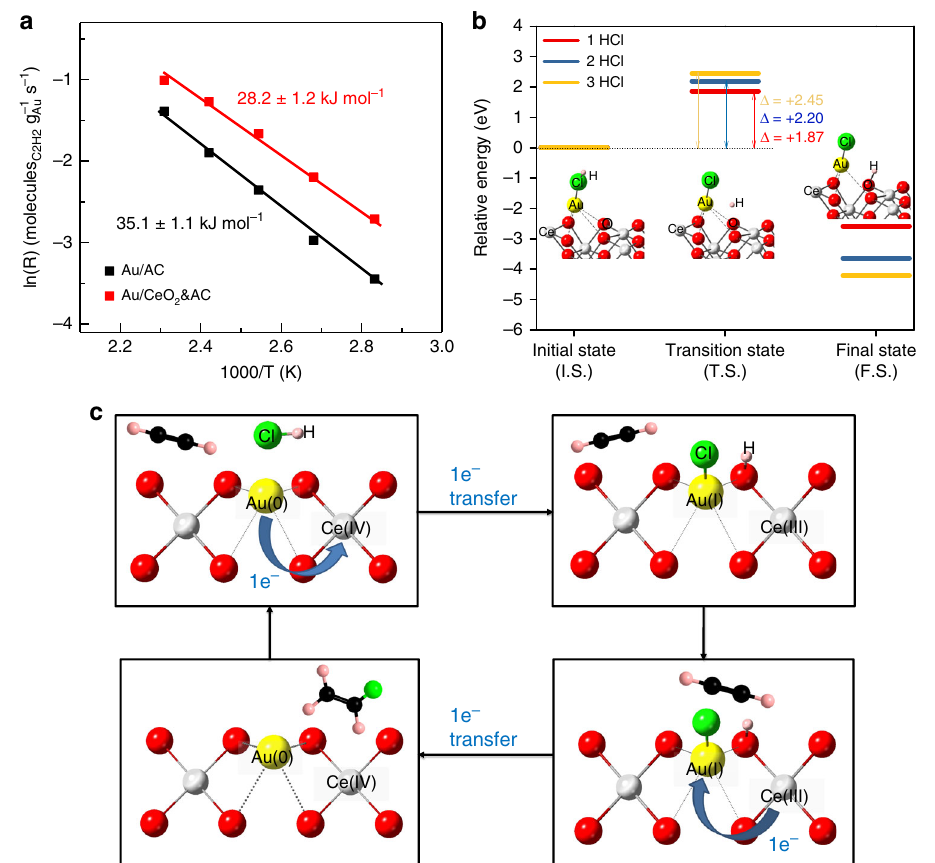
Fig. 4 Experimental and theoretical catalytic activity. a Arrhenius plots for 1.0 wt% Au/AC and 1.0 wt% Au/CeO 2 &AC (the number after ‘ ± ’ represents the error). b The potential energy diagrams for 1HCl, 2HCl, and 3HCl molecules on Au/CeO 2 (110) surface with the optimized geometry of the initial state, transition state, and fi nal state, respectively (Supplementary Figure 10). Oxygen, cerium, gold, chloride, and hydrogen are depicted in red, white, yellow, green, and grey, respectively. c The Au(0)/Au(I) redox switching mediated by Ce(IV)/Ce(III) over Au/CeO 2 &AC in acetylene hydrochlorination to vinyl